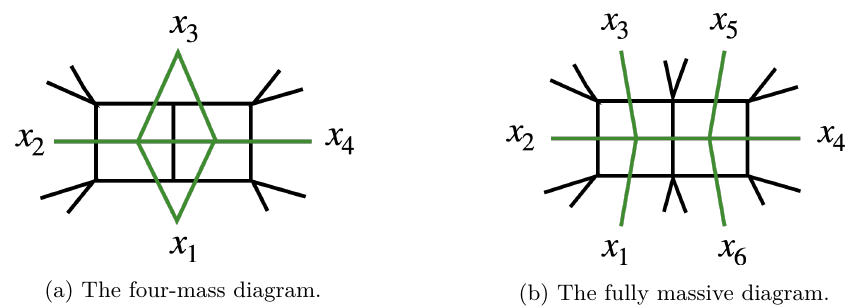
Figure 12 . Flat-space two-loop ladder diagrams in momentum space (in black) and their dual diagrams (in green). The diagram (a) is a special limit of (b) obtained by taking x and x 3 → x 5